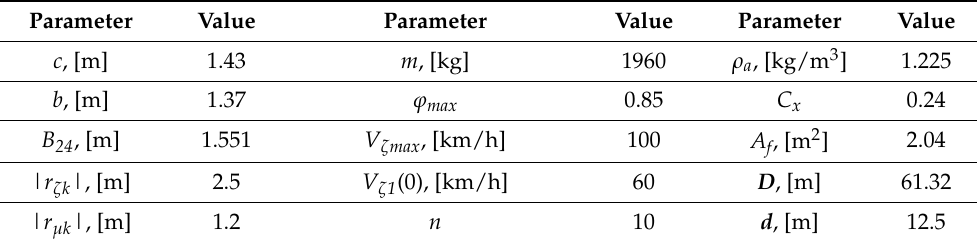
Table 2. Data for simulating the AV motion prediction.